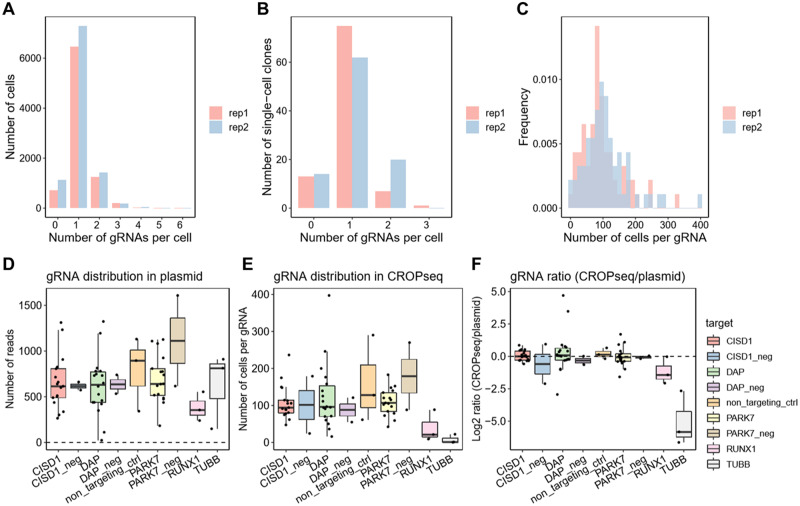
Guide RNA distributions. (A) The distribution of number of gRNA per cell detected from scRNAseq. (B) Similar distributions were observed for amplified gDNA insertions in 96 single-cell clones. (C) Histogram showing the number of cells containing each gRNA in the two replicates. (D) Raw read counts of each gRNA in the pooled library with respect to the candidate eSNPs or negative controls. (E) Number of cells assigned to each gRNA in scRNAseq shows a similar profile. (F) Log2 ratio of normalized RNA to DNA implying no deviation from expected equivalence, except for positive controls in the essential genes RUNX1 and TUBB.